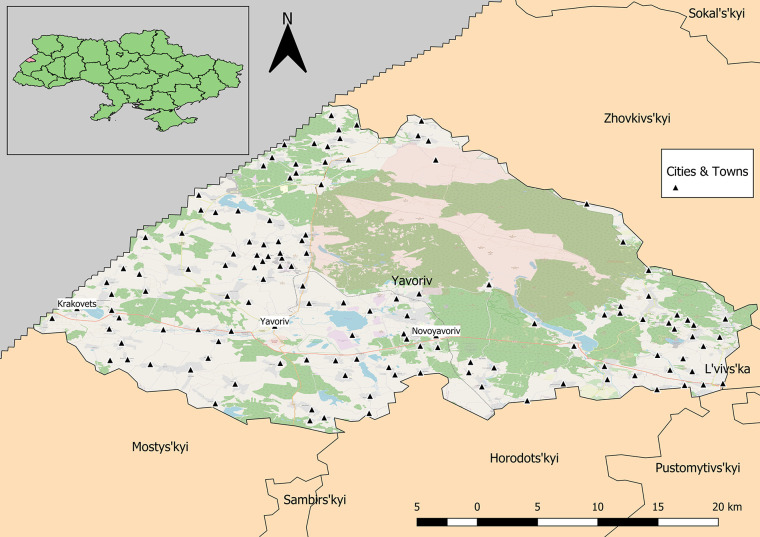
Yavoriv rayon in Lviv Oblast, Ukraine. Cities and towns are distributed across the rayon with the exception of the protected military and natural areas in the northeastern region.